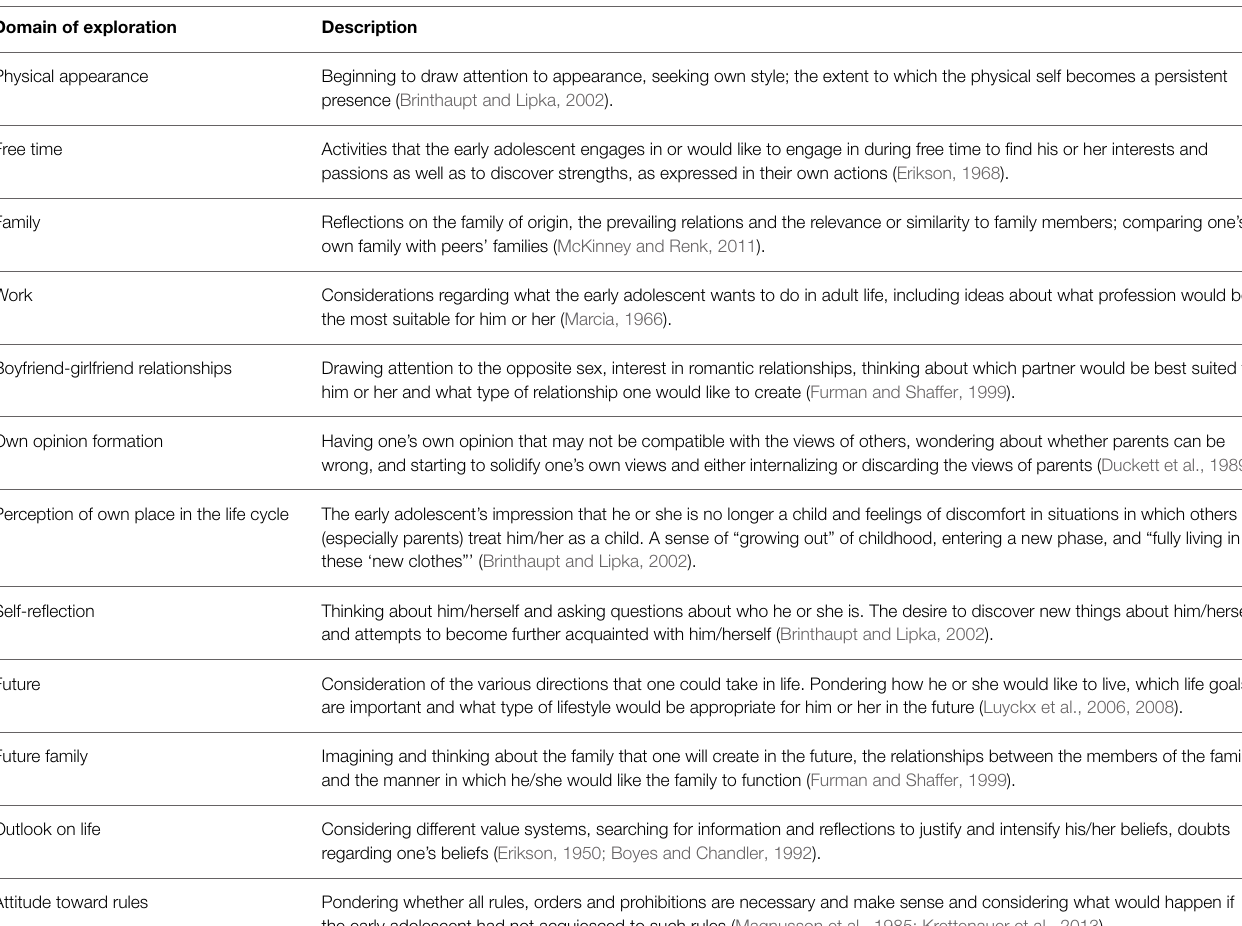
TABLE 1 | Domains of